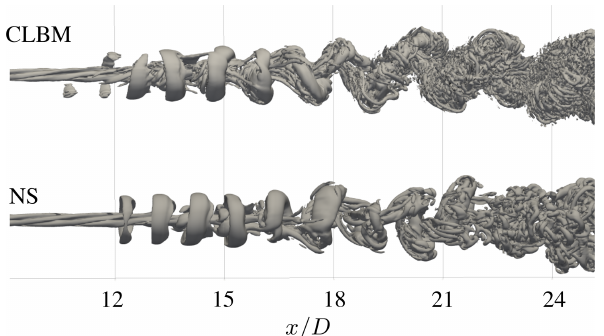
Figure 11. Rendering of the instantaneous contours of the Q cri- terion ( Q = 0 . 0005) in the far wake with the CLBM and NS with (cid:49)x = D/